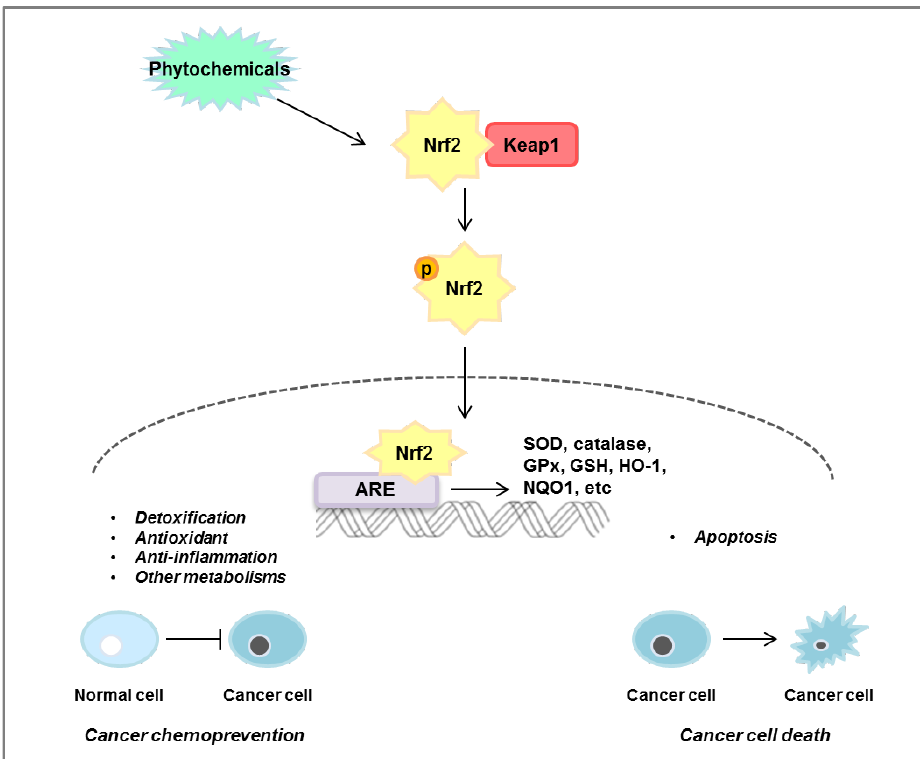
Figure 6. Mechanisms of Nrf2/KEAP1 pathway regulated by phytochemicals. Phytochemicals induce nuclear translocation of Nrf2, which then binds to the ARE in the nucleus, leading to the expression of siperoxide dismutase (SOD), catalase, glutathione peroxidase (GPx), glytathione (GSH), heme oxygenase-1 (HO-1), and NAD(P)H quinone oxidoreductase 1 (NQO1). This pathway plays an important role in cancer chemoprevention by regulating detoxification, antioxidants, anti-inflammation, and other metabolisms in normal cells. Conversely, phytochemicals induce apoptosis in cancer cells through regulation of the Nrf2/KEAP1 pathway.